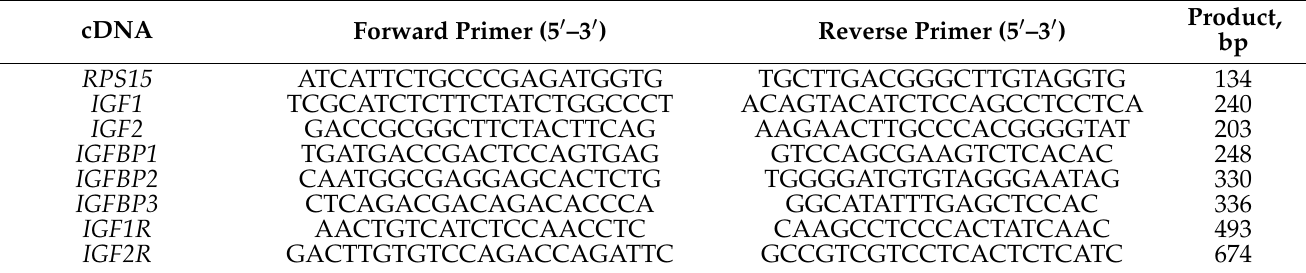
Table 7. Primers and product sizes for cDNA used in